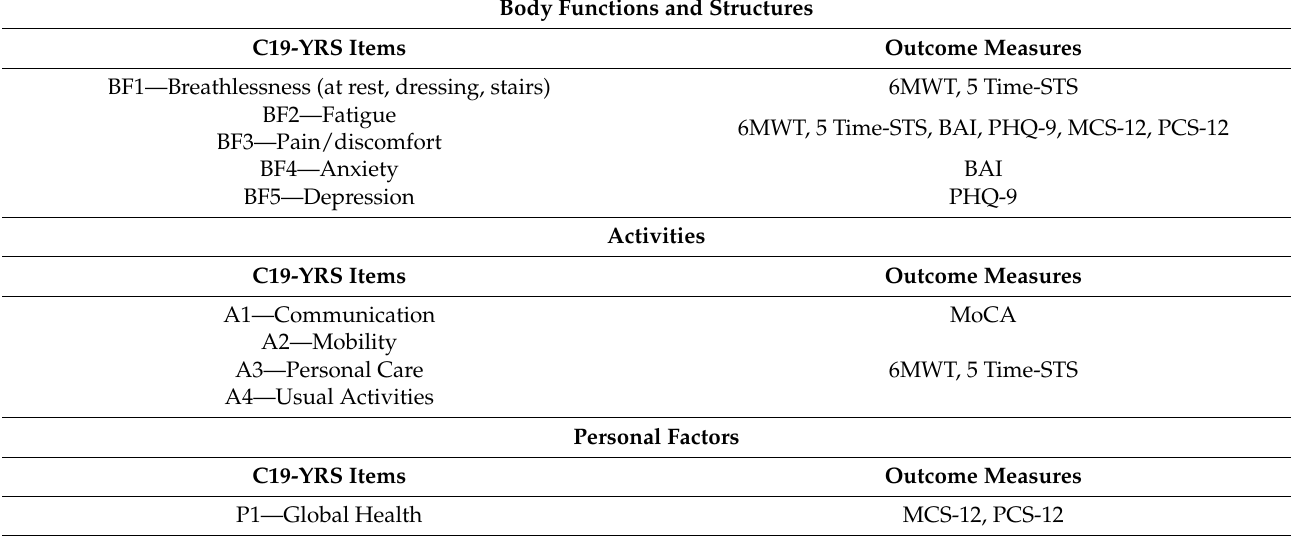
Table 1. C19-YRS items and related Outcome measures within a ICF framework.